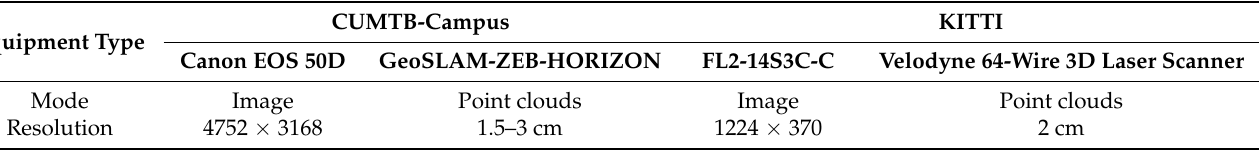
Table 1. Equipment parameters of two